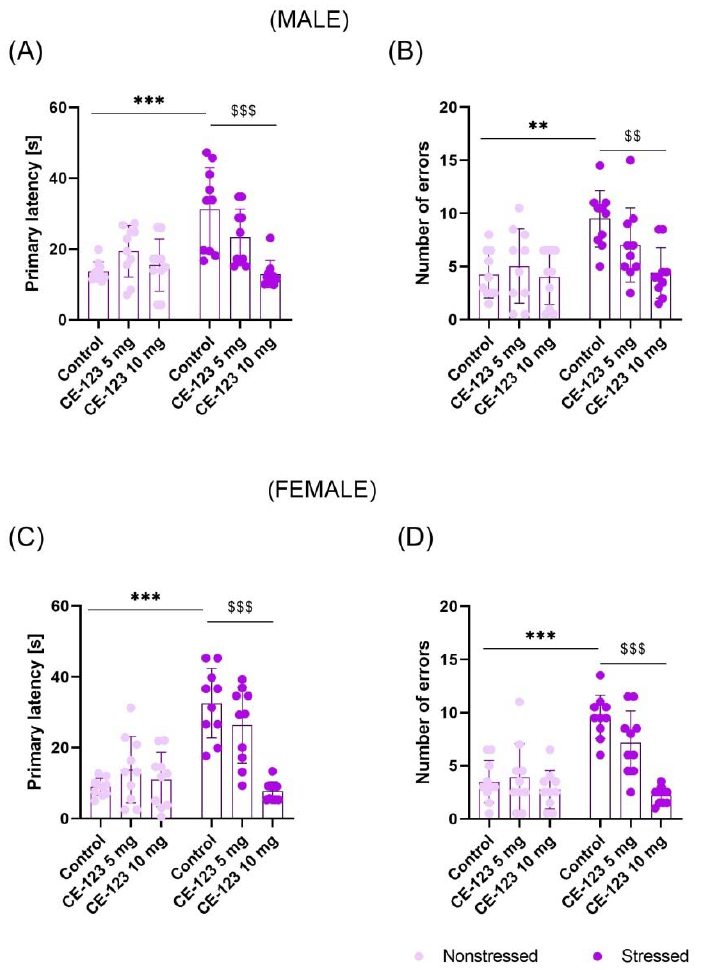
Figure 2. Impact of CE-123 (5 mg/kg and 10 mg/kg) or vehicle given prior to each acquisition session on the primary latency for males ( A ) and females ( C ) and number of errors for males ( B ) and females ( D ) in the probe-trial of the Barnes maze task in adolescent (PND34) rats. Wistar rats were subjected *** p < 0.001 Stressed/Vehicle vs. Nonstressed/Vehicle; $$ p < 0.01, $$$ p < 0.001; Stressed/CE-123 10 mg/kg vs. Stressed/Vehicle; PND—postnatal